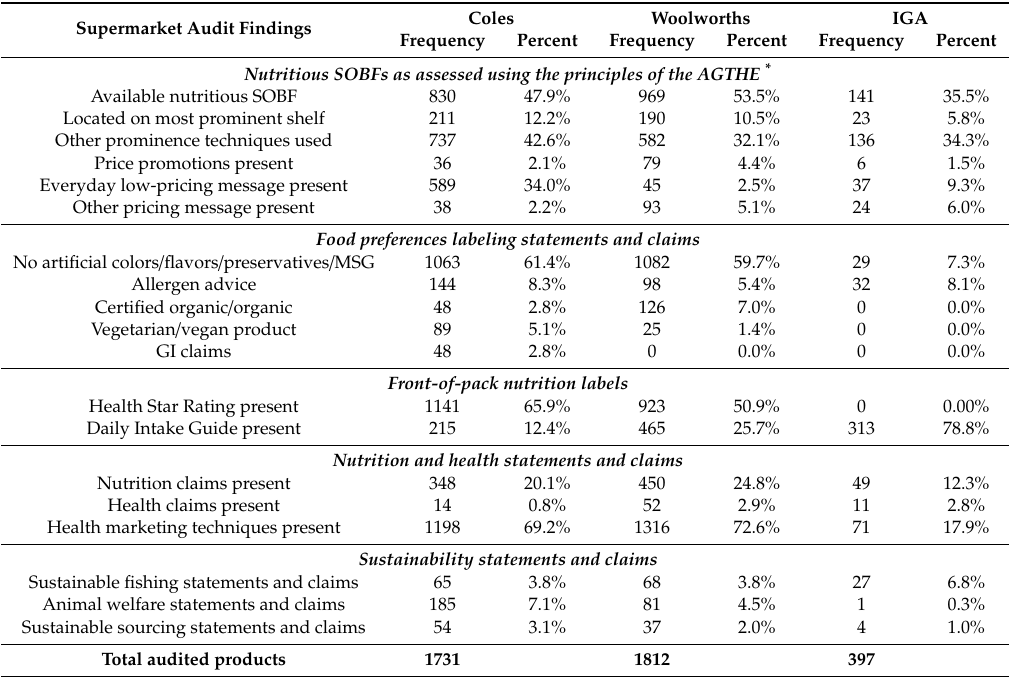
Table 3. Evidence of Australian supermarkets putting public health nutrition-related CSR policies into practice. Supermarket Audit Findings